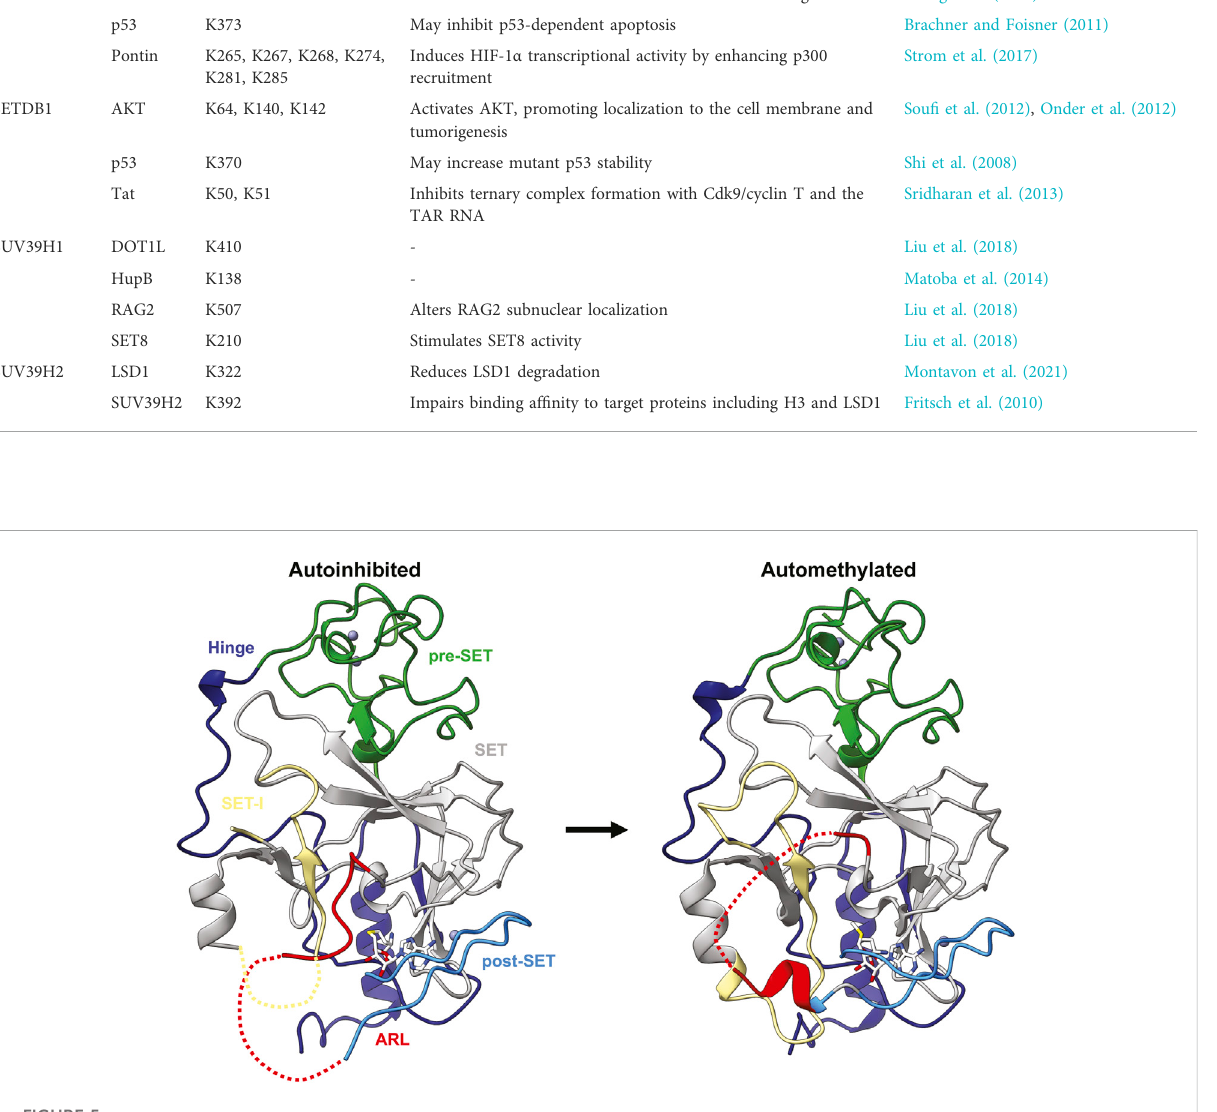
FIGURE 5 Clr4 automethylation-induced conformational switch. Structure of the autoinhibited (left; PDB ID 6BOX) and automethylated (right; PDB ID 6BP4) Clr4 catalytic domains with domains coloured the same as Figure 1 with the autoregulatory loop coloured